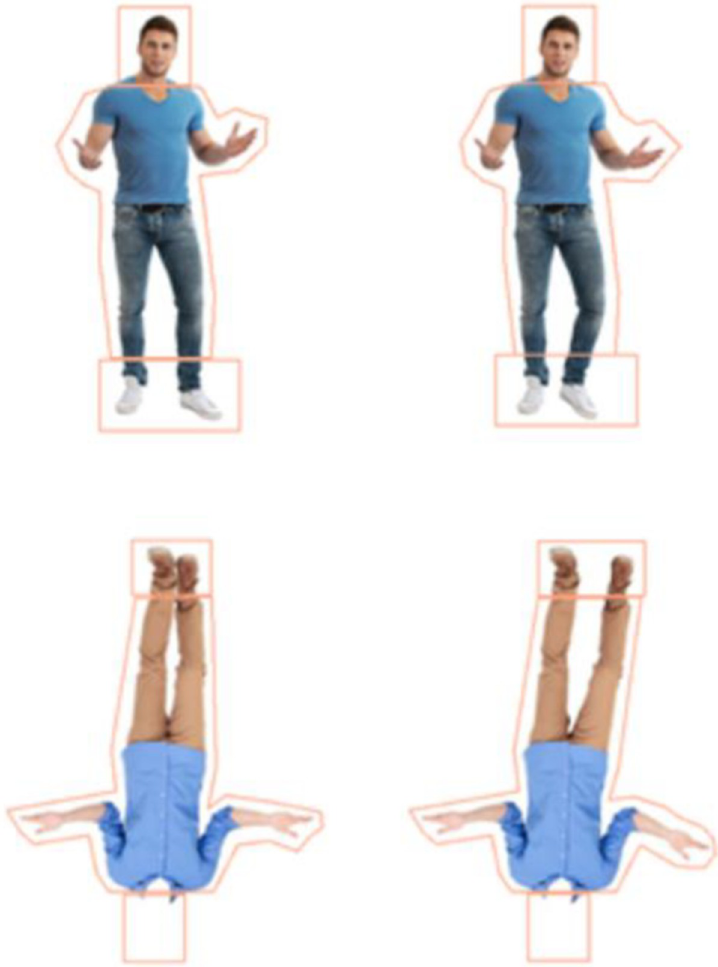
Fig 2. Posture task whole figure upright (WFU) pair and headless inverted (HLI) pair along with interest areas (IAs) surrounding the heads, bodies, and feet. Posture discrimination task. Twelve pairs of stimuli were sourced from Axelsson et al. [10]. These were photographs of forward-facing adult Caucasian male human figures, sourced from Shutterstock.com. All figures had short, dark brown hair and wore similar clothing (plain, blue shirts and trousers) to reduce attention to clothing or hair. They all had similar body shapes. The figures in each pair were the same identity with the same clothing and dif- fered only in posture (see Fig 2). Using Adobe Photoshop (CS6), the postures were altered in 2D space by rotating or shifting the limbs of the figures up or down. Four pairs differed in both an arm and leg position, four pairs in only a leg position, and four pairs in only an arm position. The angle of the limb positions were changed in Photoshop. For the pairs that dif- fered in the arm and leg positions, the angles were altered by 10–15˚. For the pairs that differed in only one limb (arm or leg), the angles were altered by 20–30˚. All poses are biologically pos- sible as tested by one of the authors (ELA). Head positions in the whole figure conditions were identical within a pair. The average size of the whole figures was 8.44˚ × 12.84˚ visual angle at 900mm distance and the headless figures were 8.44˚ × 11.36˚.